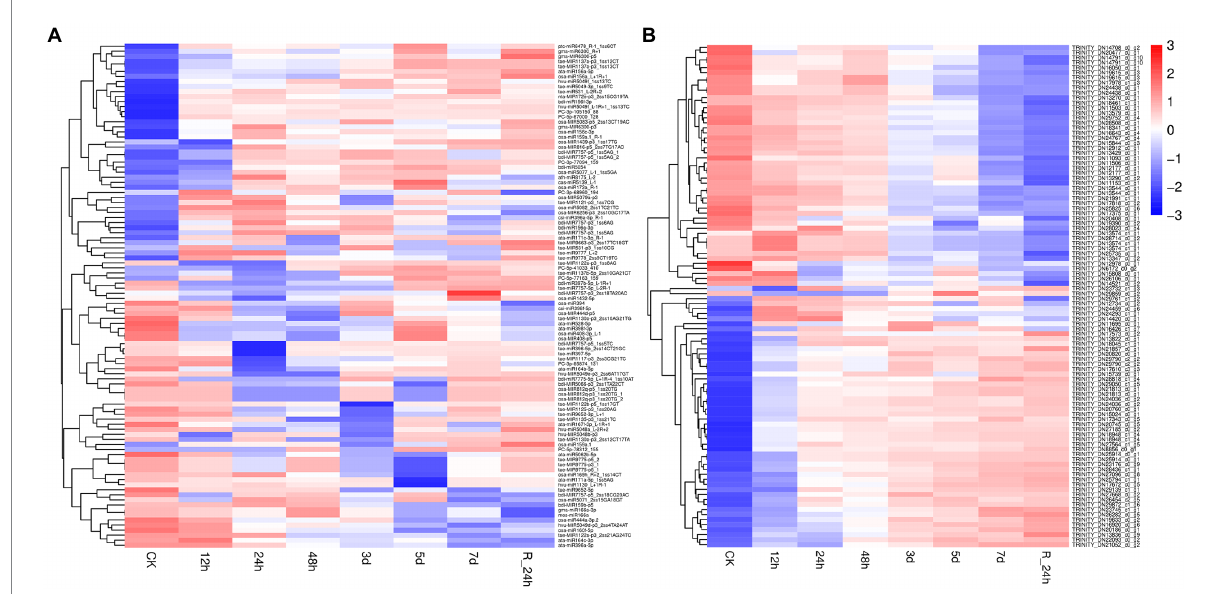
FIGURE 4 A combined view of the levels of expression between differentially expressed miRNAs (A) and their target genes (B) in Agropyron mongolicum in eight different drought treatment durations. The original expression values of miRNAs and their target genes were normalized by Z-score